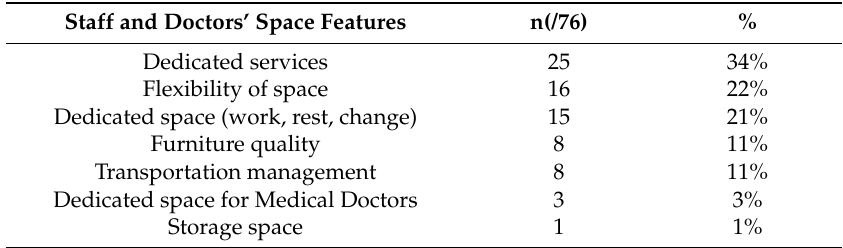
Table 6. Number and percentage of indicators grouped according to Staff and doctors’ space features topics.